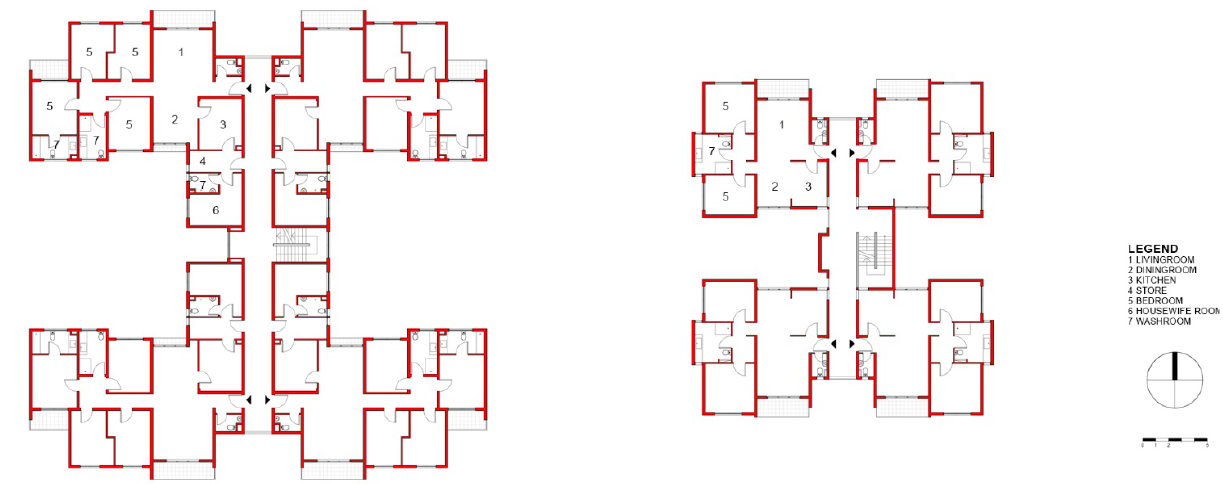
Figure 59. The Umudugudu Kigali Vision: Type floor condominium (2-4 bedrooms). Drawing by Manlio Michieletto.